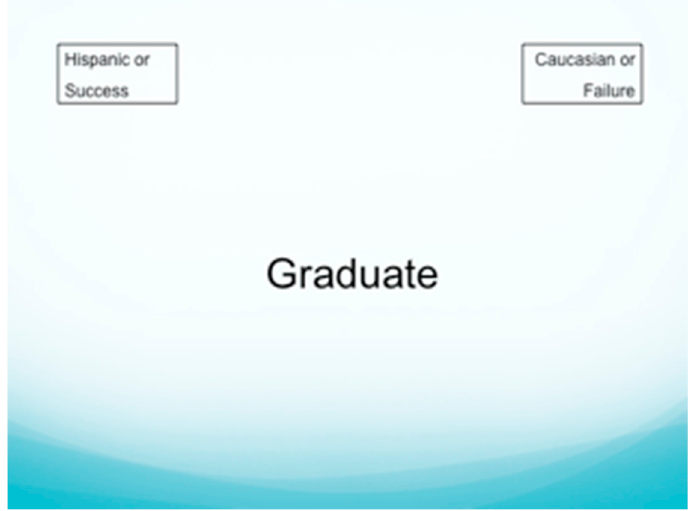
Figure A1. Sample screen from the IAT with a word as the stimulus.